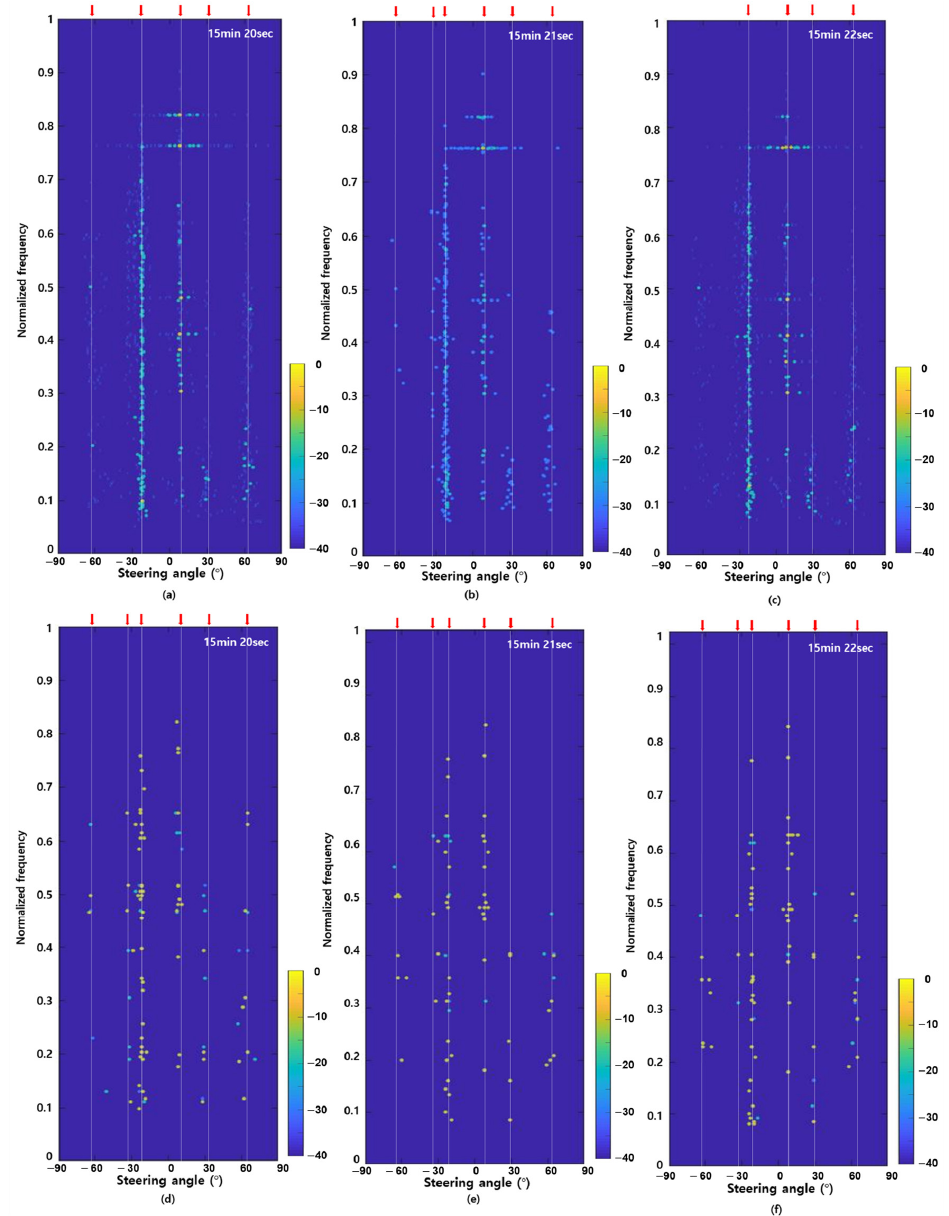
Figure 5. Frequency-azimuth plots using ( a – c ) conventional detection method with detection threshold; ( d – f ) proposed detection method using the MM-SBL at the 15 min 20 s to 22 s. From the characteristics of the frequency components of each target in Figure 5, most tonal frequency components of the fishing boats (at approximately −60°, −30°, 30° and 65°) were distributed below 0.5 of the normalized frequency. On the other hand, most of the tonal frequency components of the experimental ship (at approximately 10°) were distrib- uted above 0.5 of the normalized frequency (higher tonnage than fishing boats). Thus, we can identify the target according to the frequency distribution of the FRAZ plot results.